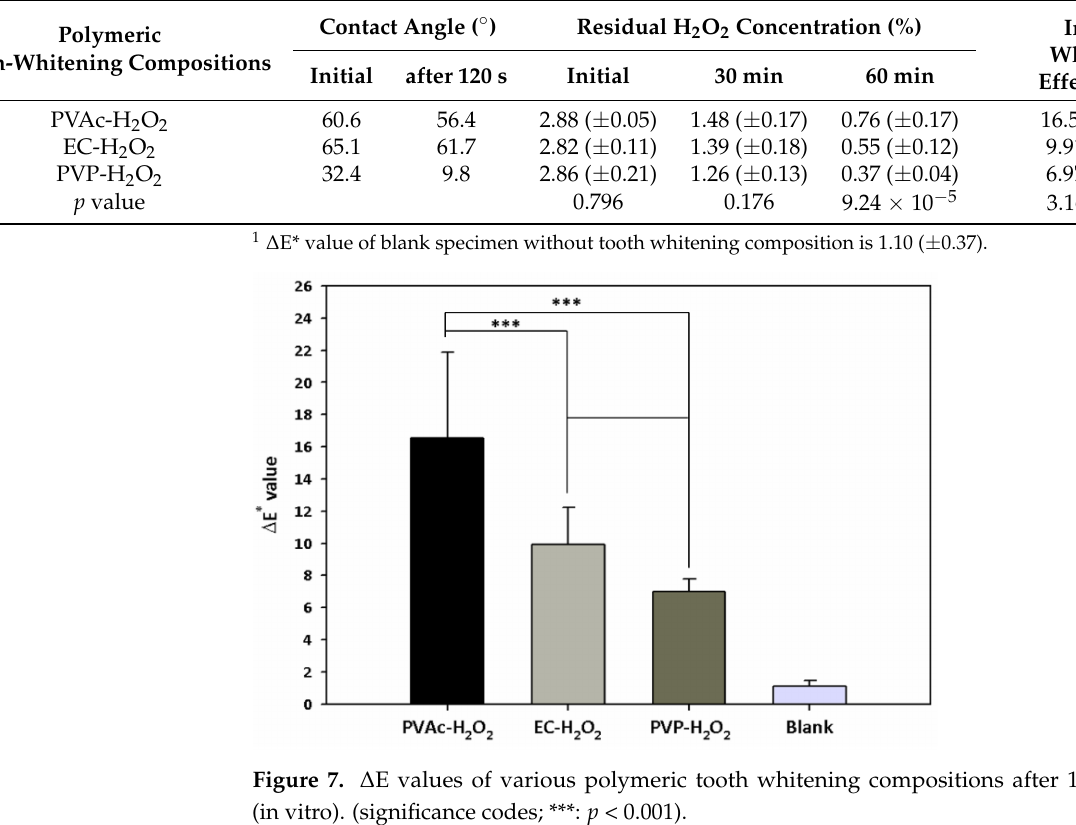
surface; Table S1: Residual H 2 O 2 concentration of polymeric whitening compositions (initial); Table S2: Residual H 2 O 2 concentration of polymeric whitening compositions (exposed 30 min); Table S3: Residual H 2 O 2 concentration of polymeric whitening compositions (exposed 60 min); Table S4: L* a* b* and ∆ E values of initial and H 2 O 2 treated conditions for whitening